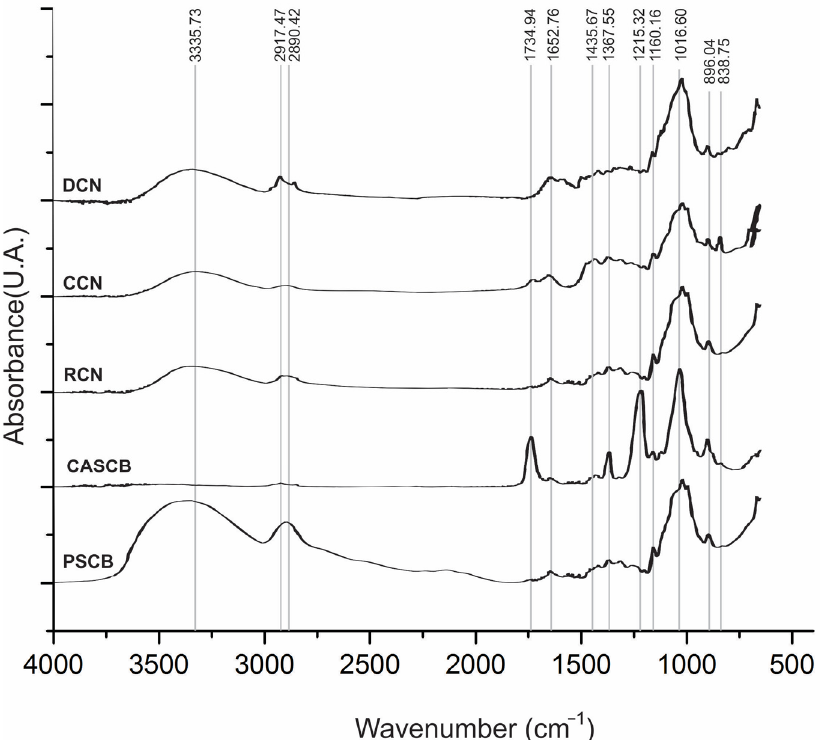
Figure 1. ATR–FTIR spectrum for cellulose samples obtained in the different stages of processing: pure sugarcane bagasse (PSCB), cellulose acetate from sugarcane bagasse (CASCB), regenerated cellulose fibers (RCN), cationic cellulose fibers (CCN), and dyed cellulose fibers (DCN). The ATR–FTIR spectrum for CASCB showed characteristic vibrational bands of the acetate functional group of cellulose acetate at 1735 cm − 1 (C = O stretching), 1367 cm − 1 (C–CH 3 ), and 1215 cm − 1 (C–O–C). Similar results were reported by Rodrigues Filho et al. [15]. The RCN fibers showed the same vibrational bands of the cellulose (PSCB), indicating that the process used for the regeneration of cellulose was successful and that the electrospinning process did not generate further chemical changes. The results for CCN showed a signal at 1436 cm − 1 that corresponded to the tension of the C–N group for cationizing (CHPTAC) and another band at approximately 839 cm − 1 that can be attributed to the stretching of the corresponding epoxy ring [6]. DCN and CCN showed similar IR spectra, and new